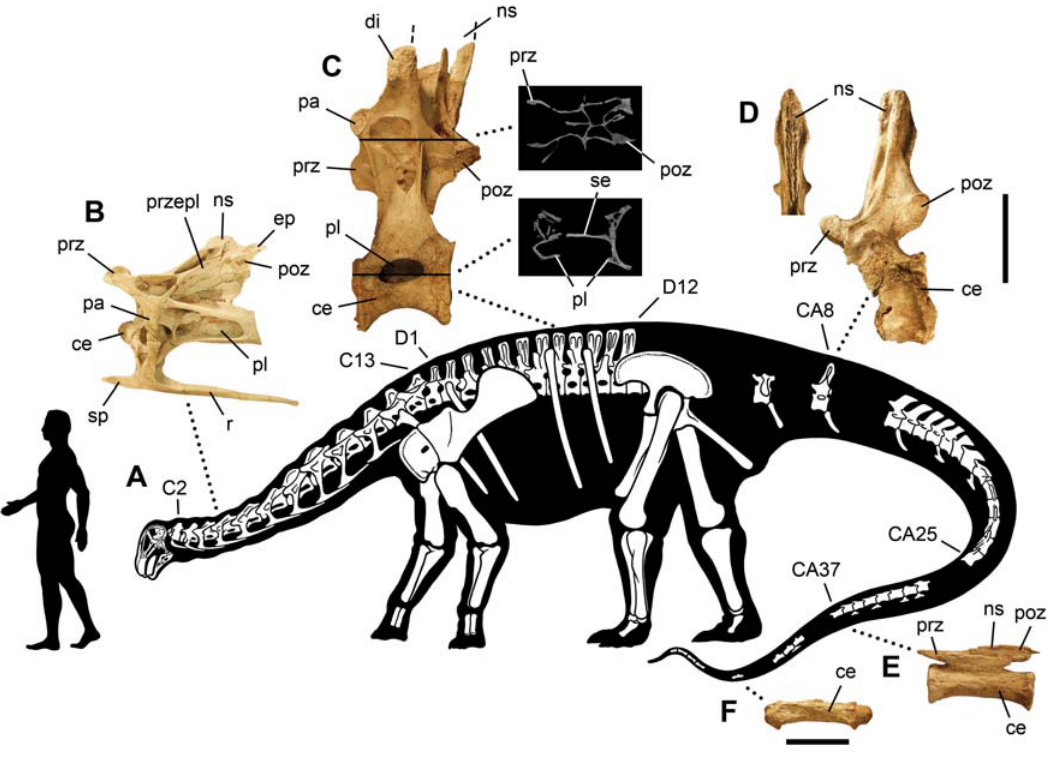
Figure 3. Skeleton of Nigersaurustaqueti. Skeletal reconstruction is based mainly on four specimens (MNN GAD513, GAD 515-518). (A)-Skeletal silhouette showing preserved bones. (B)-Fifth cervical vertebra in lateral view. (C)-Eighth dorsal vertebra in lateral view with two cross-sections from a m CT scan. (D)-Probable eighth caudal vertebra in lateral view with anterior view of the neural spine. (E)-Caudal vertebra (ca. CA37) with low neural spine. (F)-Distal caudal vertebra (ca. CA47) with biconvex centrum and rudimentary neural arch. Human silhouette equals 1.68 meters (5 feet 6 inches). Upper scale bar equals 10 cm for B-E; lower scale bar equals 5 cm for F. Abbreviations : C , cervical vertebra; CA , caudal vertebra; ce , centrum; D , dorsal vertebra; di , diapophysis; ep , epipophysis; ns , neural spine; pa , parapophysis; pl , pleurocoel; poz , postzygapophysis; prz , prezygapophysis; przepl , prezygapophyseal-epipophyseal lamina; r , rib; se , septum; sp , spine.